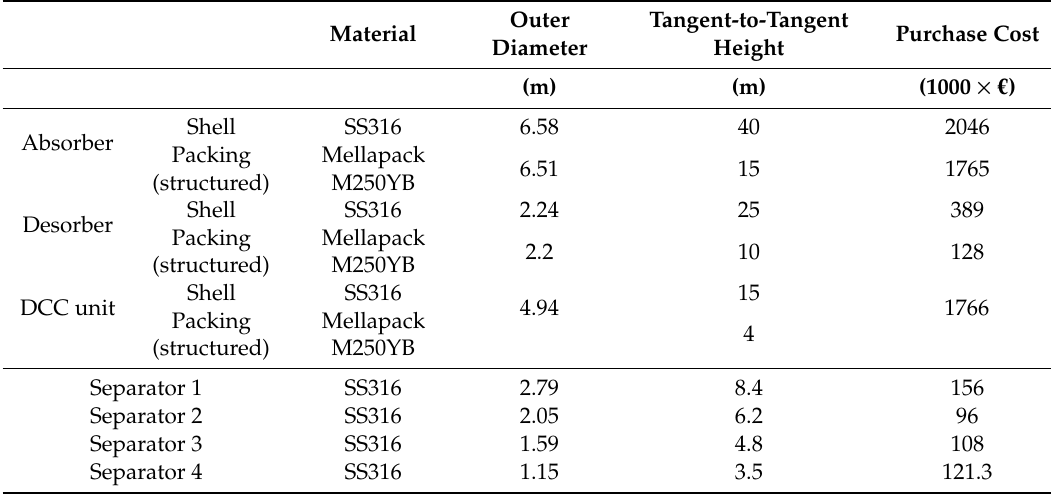
Table A2. Columns and pressure vessel dimensions and purchase costs from Aspen In-Plant Cost Estimator V11 (purchased cost year: 2018).